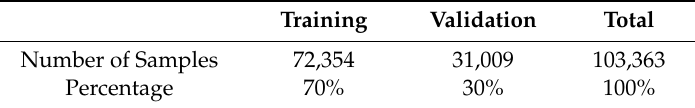
Table 5. Dataset distribution for training.